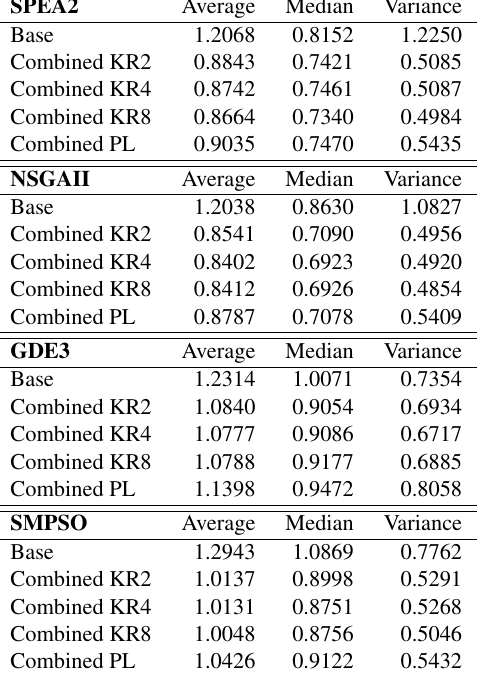
Table 3. EE - Estimation Error